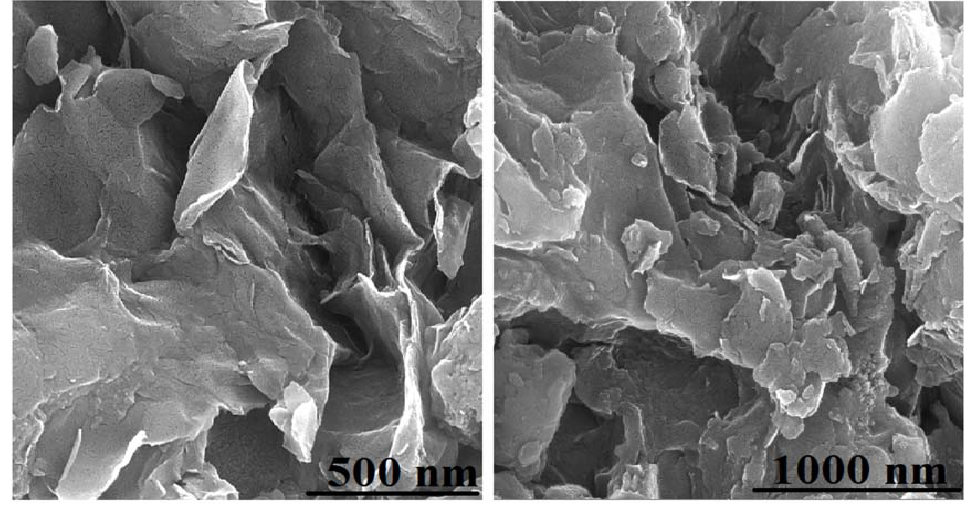
Figure 2. Field emission scanning electron microscopy images of the modified clay (AS ‐ BEN).